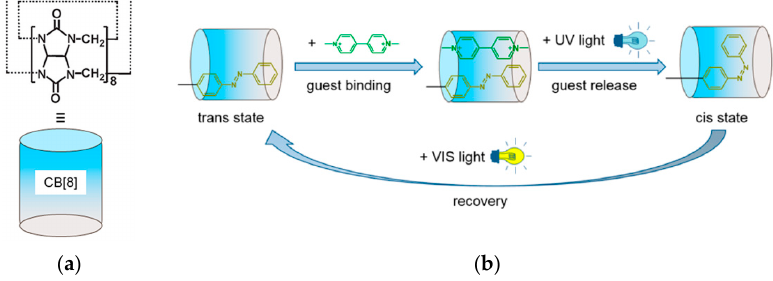
Figure 13. Chemical structure of cucurbit[8]uril (CB[8]) ( a ) and binding and release of methyl viologen (MV) in LbL film containing CB[8] ( b ). Reprinted with permission from Refs. [100,101]. Copyright 2015 and 2016 American Chemical Society.